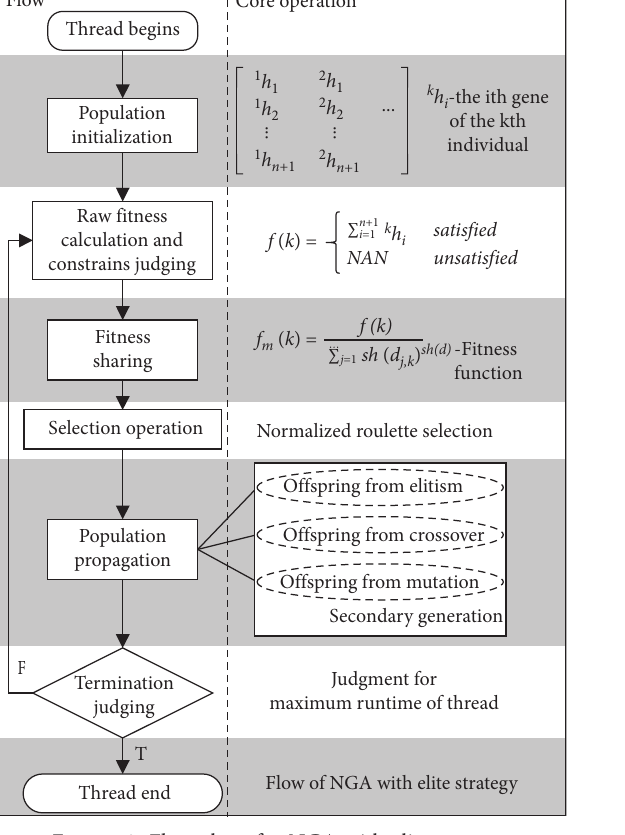
Figure 2: Flow chart for NGA with elite